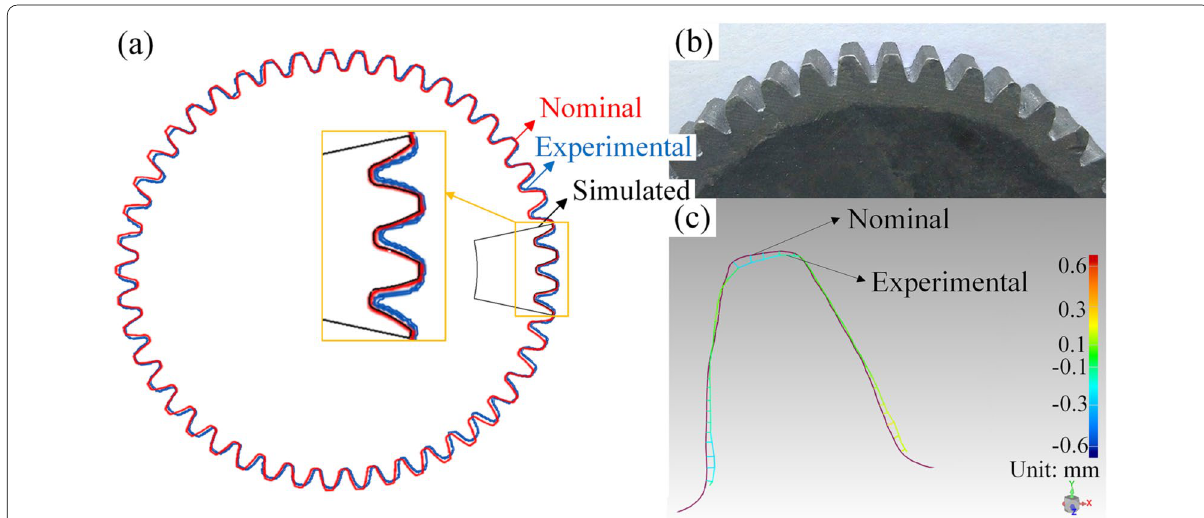
Figure 16 (a) The complete and detailed tooth profile of the sample obtained from simulations and experiments, (b) the formed gear in experiments and (c) the dimensional deviation with a nominal tooth